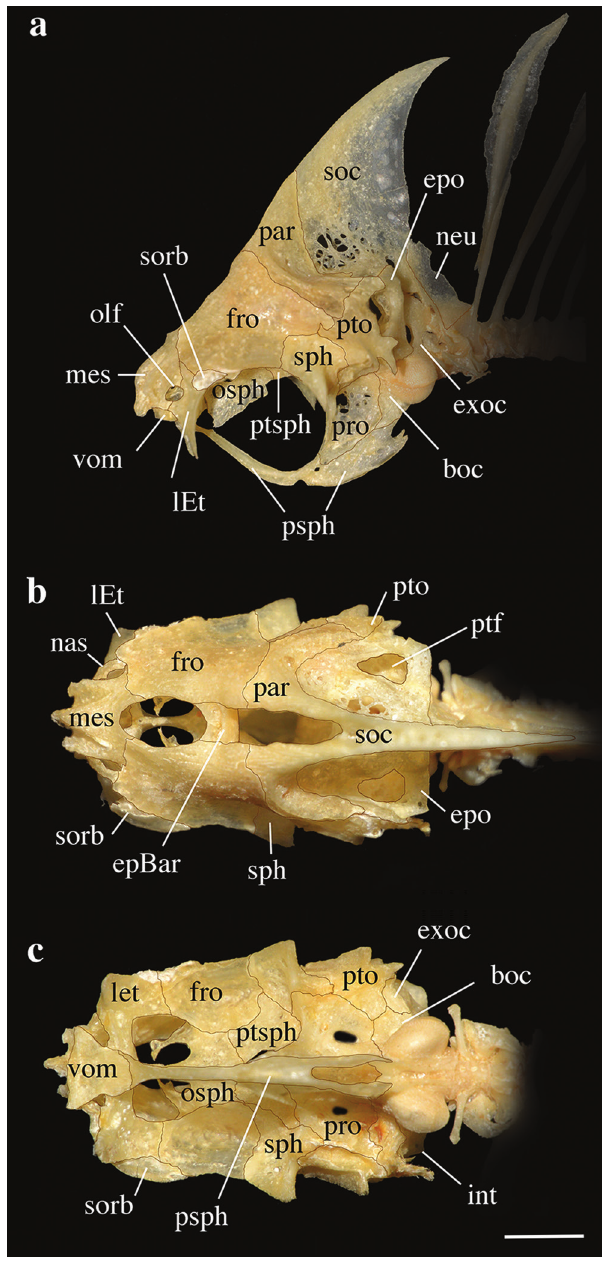
Fig. 4. Neurocranium of Metynnis melanogrammus ,